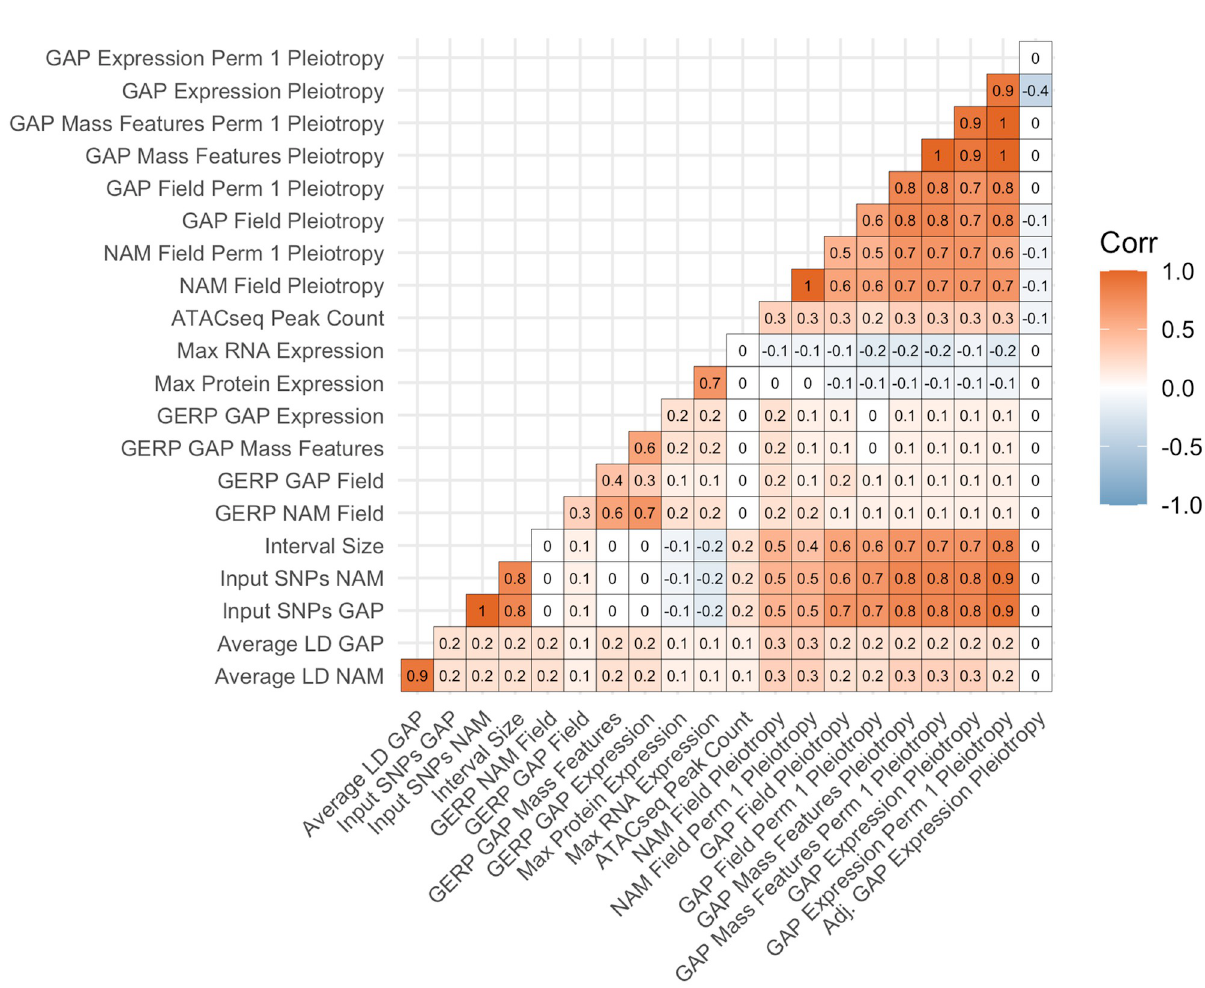
Fig 3. Correlation matrix of key biological, nuisance (mapping), and pleiotropy values. Values indicate the Pearson correlation between values colored by the strength of their correlation.